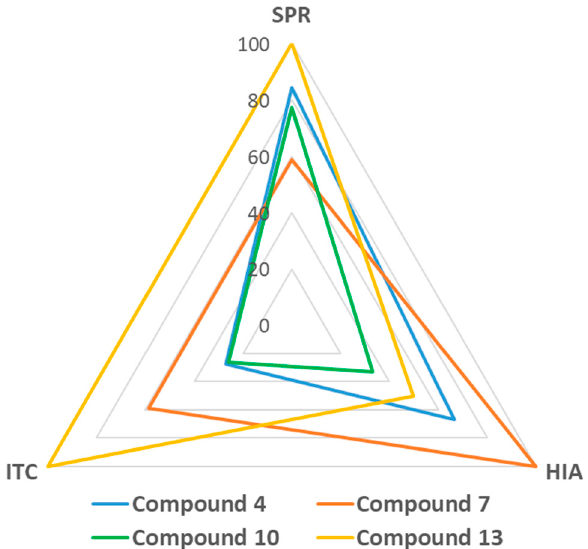
Figure 8. Comparison of effectiveness of tested compounds obtained by hemagglutination inhibition assay (HIA), SPR inhibition assay (SPR) and isothermal titration microcalorimetry (ITC). Values for parameters β (HIA and SPR) and K a (ITC) were relativized to the best inhibitor/ligand (100%) obtained by each method and compared.